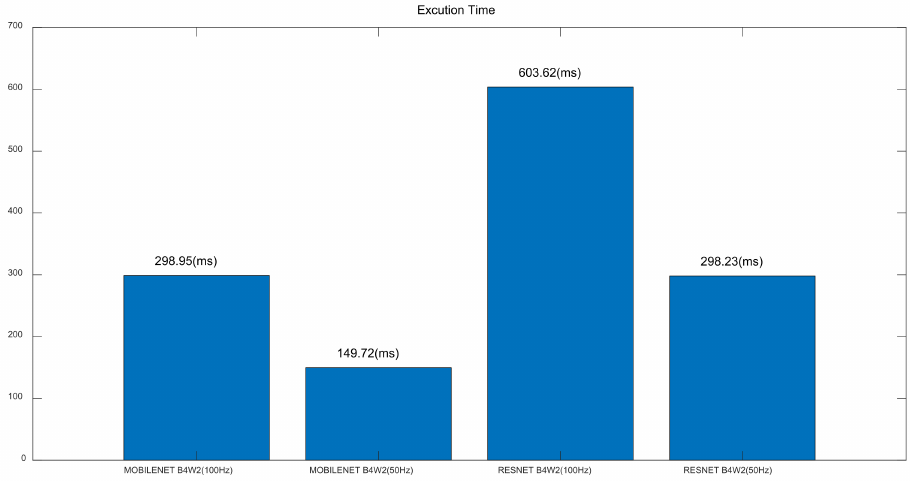
Figure 6. Execution Time.